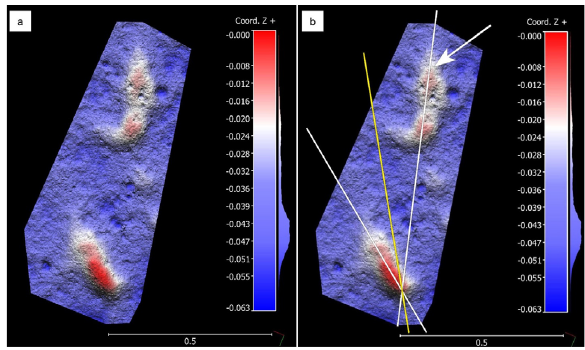
(a) Photogrammetry colour mesh of possible hominin tracks, using 64 images. Photos were taken an average 27.1 cm from the surface. The reprojection error is 0.731 pix. Vertical and horizontal scales are in metres. (b) Identical image to (a), with the addition of white lines to indicate footprint long axes, and the yellow line as a bisector; the arrow indicates faint possible hallux trace at the anterior end of Track